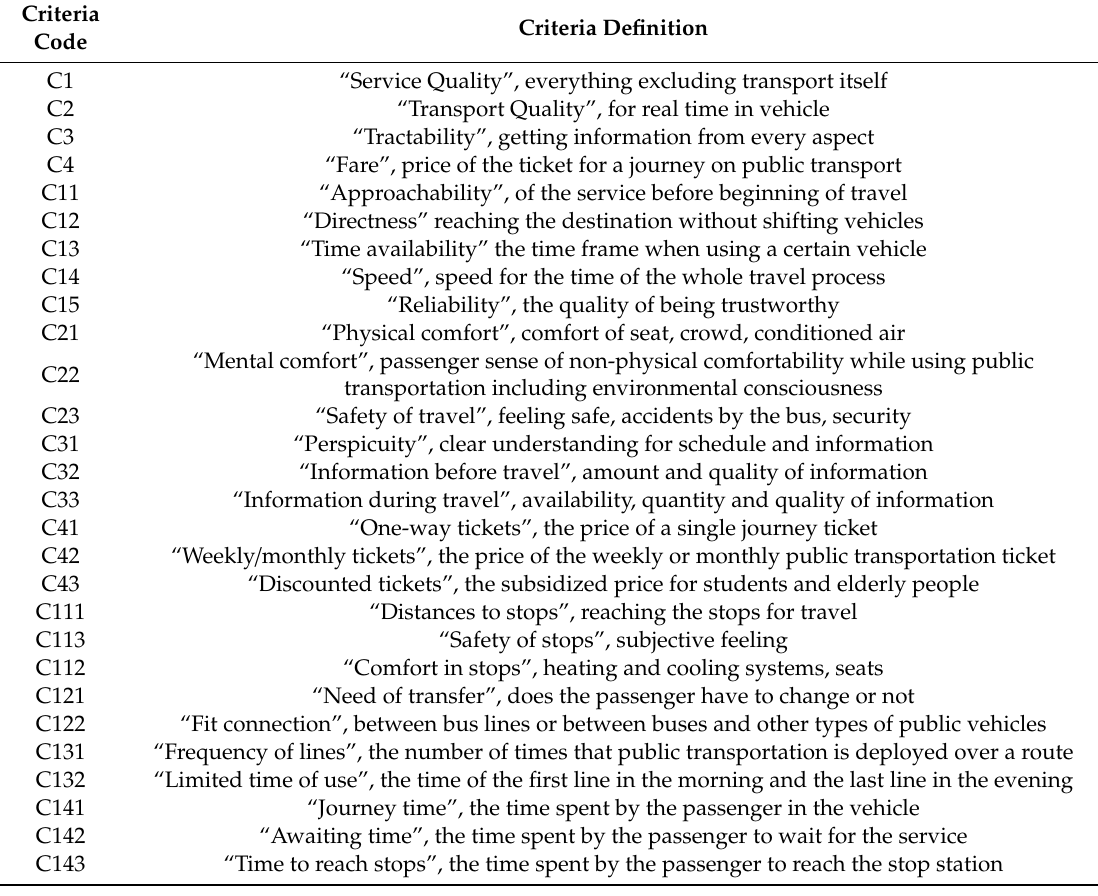
Table 3. The definition of the applied decision elements.